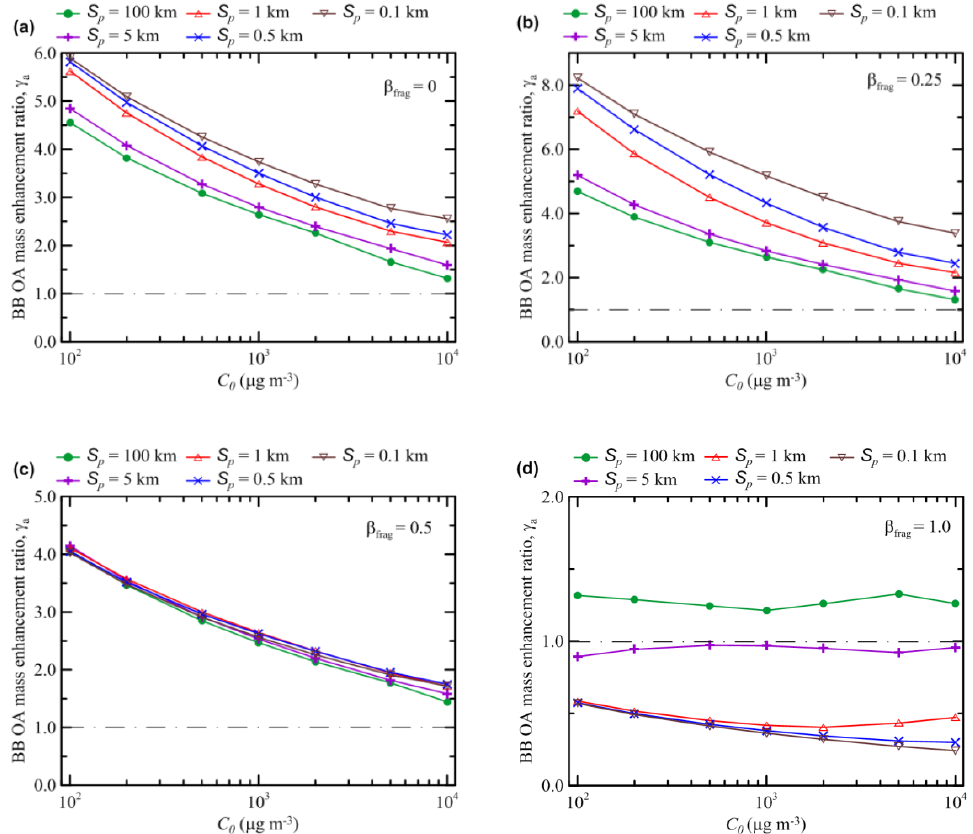
Figure 9. Dependencies of the BB OA enhancement ratio after 120h of evolution on the initial BB OA mass concentration, C 0 , according to the simulations using the S15 scheme with different values of S p and varying values of the fragmentation branching ratio: (a) β frag = 0, (b) β frag = 0 . 25, (c) β frag = 0 . 5, and (d) β frag = 1 . 0. A horizontal dashed–dotted line in each panel indicates the situation where no BB OA mass enhancement occurs ( γ a =